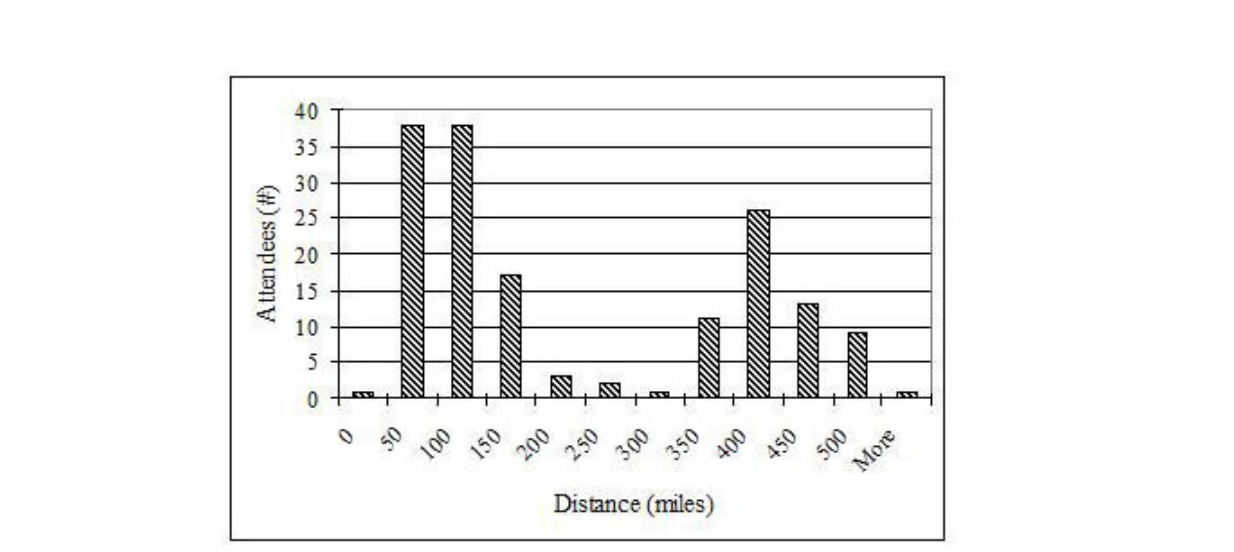
Fig. 5. Distribution of scallop attendee